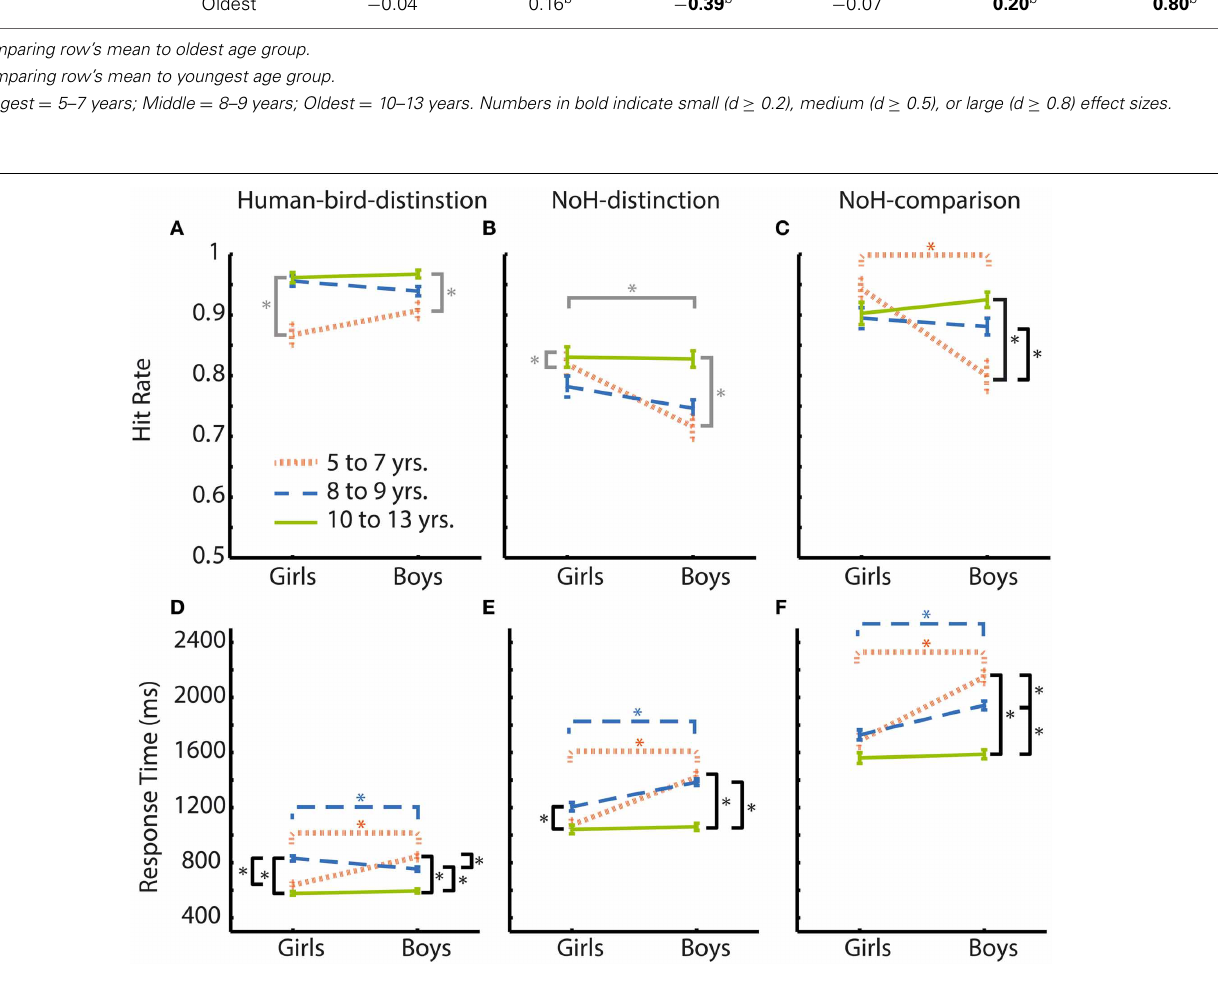
B,E ) and NoH-comparison (right, C,F ). Differences between age groups when considering the interaction age group × gender are indicated in black. Significant differences between boys and girls are marked according to age groups’ colors. Differences resulting from main effects not accompanied by an interaction are marked in gray. Asterisks mark significant differences according to post-hoc Scheffé-tests. Error bars represent